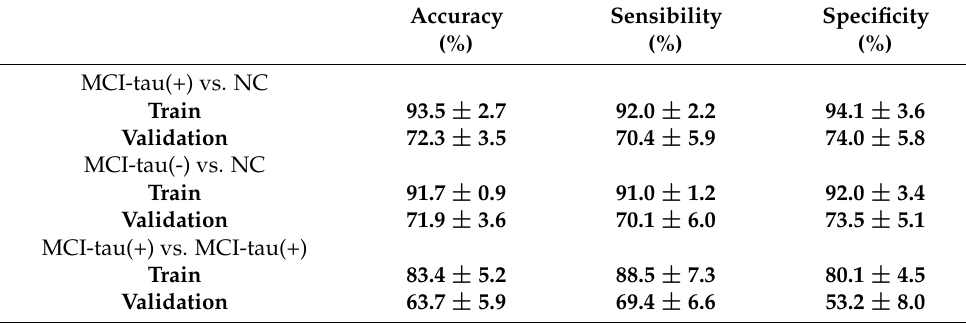
Table 4. The classification results for MCI-tau subgroups.